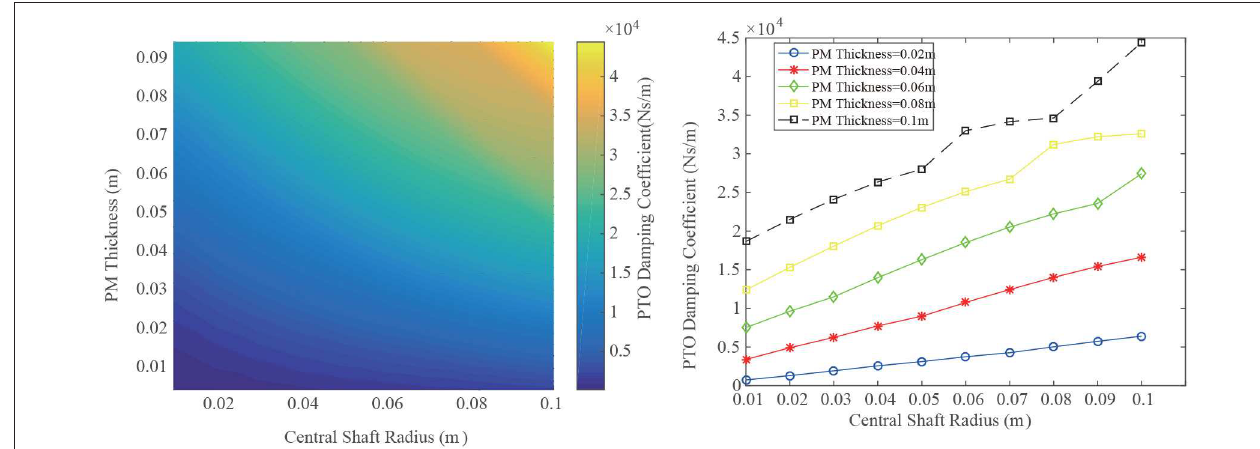
FIGURE 11 | The influence of the PM thickness and the central shaft radius.